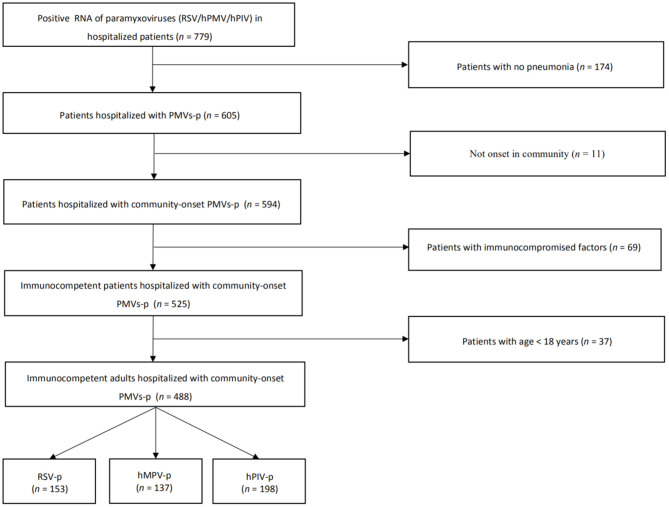
Screening algorithm of patients hospitalized with the three types of PMVs-p.